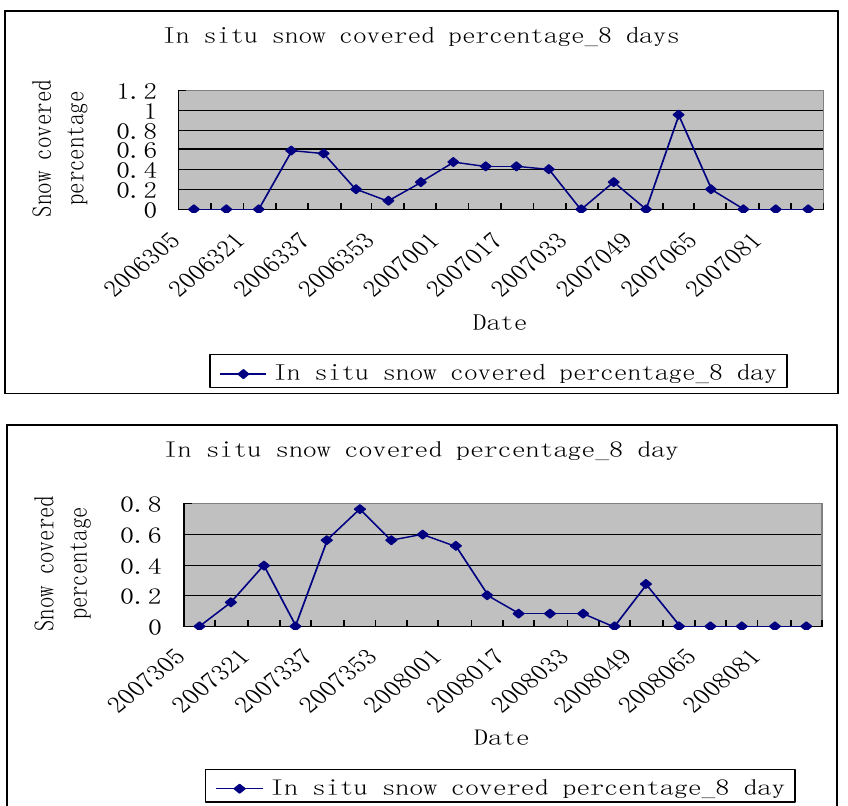
Figure 10. 8-day maximum snow cover extent for the 2006–2007 (upper) and 2007–2008 (lower) winters.